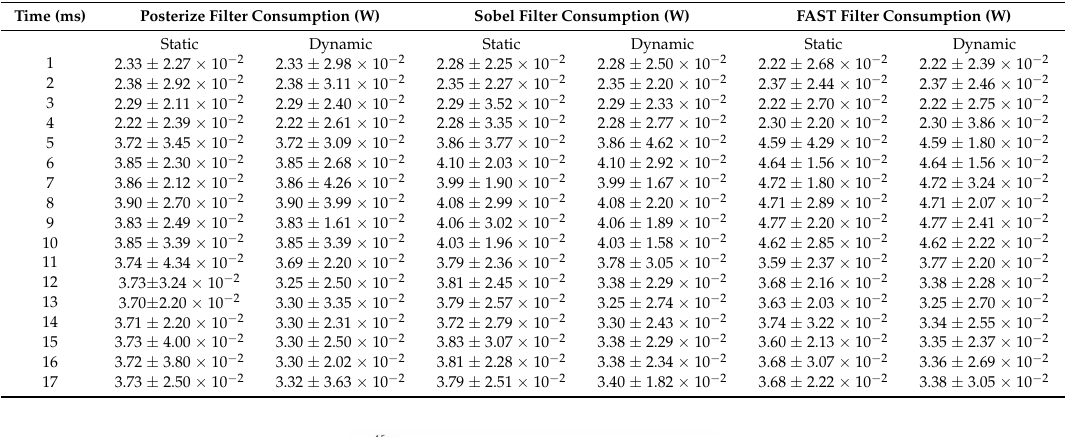
Table 5. The power consumption for the three filters in the static and dynamic configurations. The values are expressed as average value ± standard deviation over 15 measurement repetitions.